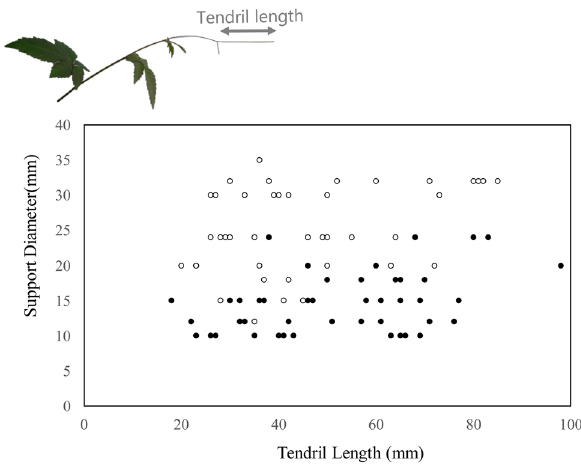
Figure 1. Relationship between tendril length, support diameter and coiling success. Each dot represents the coiling success (black) or failure